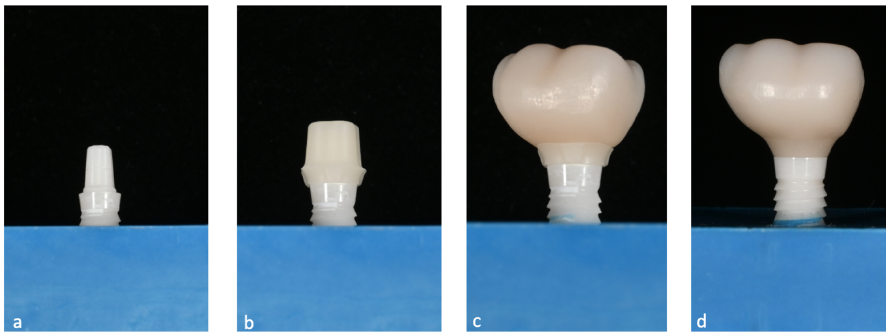
Figure 1. ( a ) One-piece ceramic implant; ( b ) Mesostructure on the implant; ( c ) Suprastructure on mesostructure on the implant; ( d ) Monolithic crown on the implant.